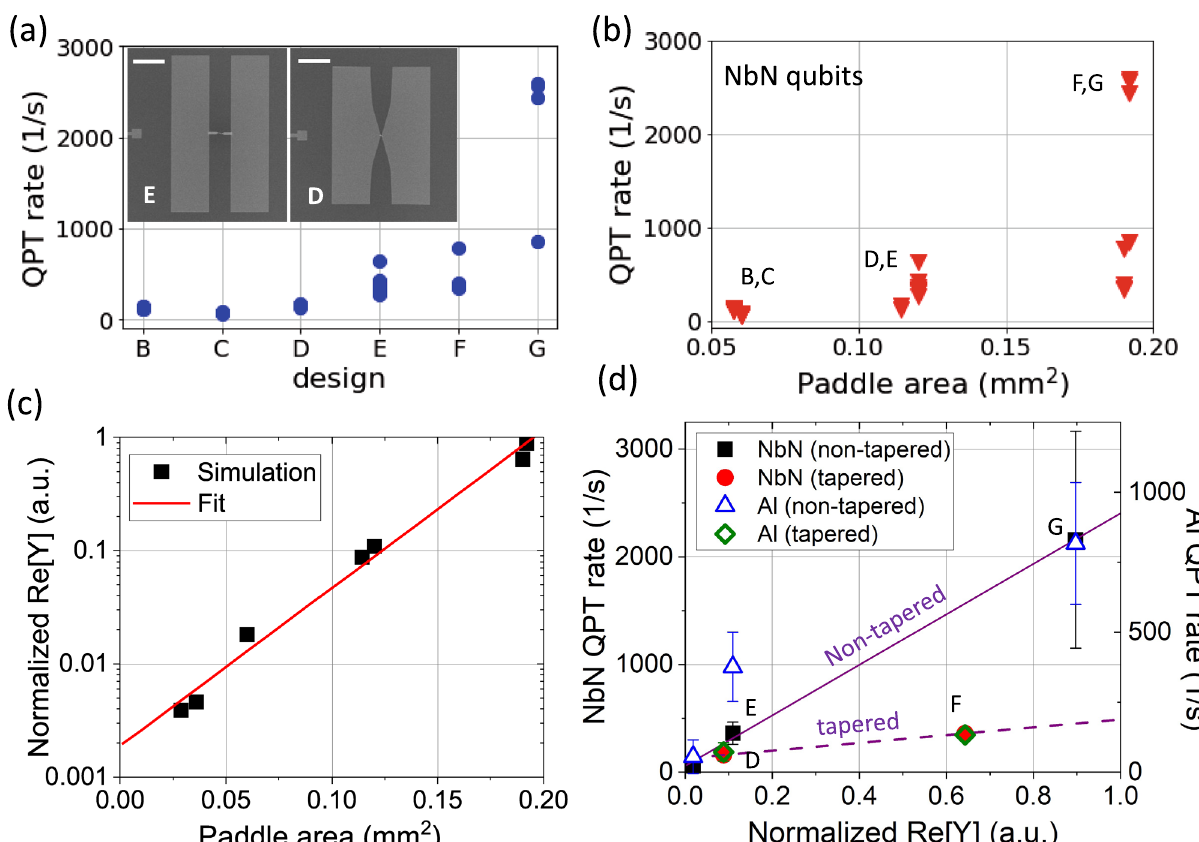
Fig. 3 Impact of qubit design on quasiparticle dynamics. a QPT rate vs. design in qubits with NbN paddles illustrating the nonlinear dependence of quasiparticle tunneling with increasing paddle dimensions, the inset shows the SEM images of tapered (D) and non-tapered (E) qubit designs, the scale bars correspond to 100 μ m. b QPT rate vs. paddle area for the same qubits, c real part of the simulated qubit admittance which follows an exponential increase with paddle area, d comparison of mean values of experimentally obtained QPT rates for NbN and Al paddle qubits vs. simulated Re[ Y ( ω